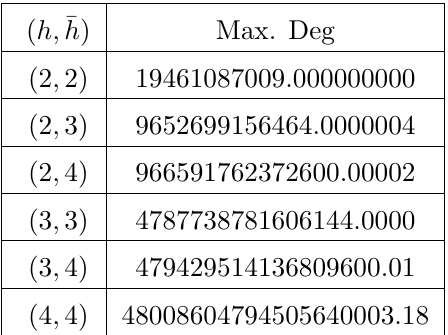
Table 11. The maximum value of degeneracies for low-lying states in putative CFT with c = 32. The maximum number of derivatives is set to N max = 55, while the spin is truncated at j max = 40.